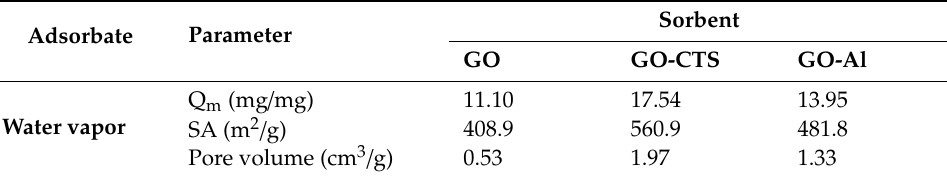
Table 2. Brunauer–Emmett–Teller (BET) adsorption isotherm parameters for GO and GO-based composites with water vapor at 298